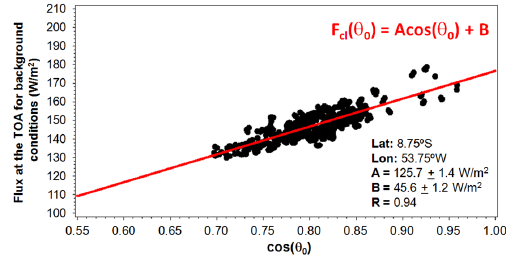
Figure 1. Example of the procedure used to obtain the flux at the top of the atmosphere (TOA) for background conditions ( F cl ) as a function of the solar zenith angle ( θ 0 ) for a 0.5 ◦ × 0.5 ◦ cell located in the Amazon Basin. In this example, 4 months worth of data over the grid cell were used, from July to October